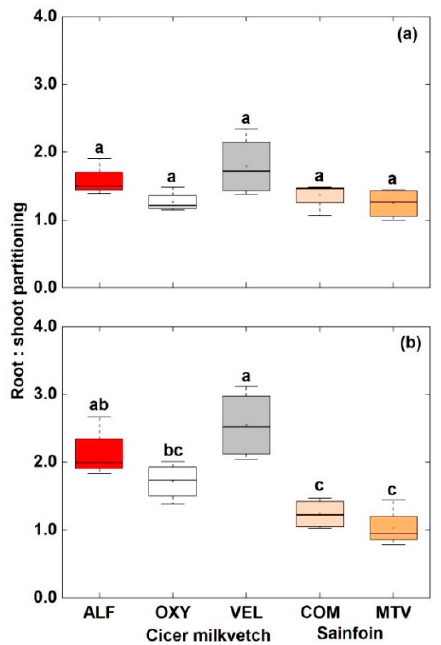
Figure 3. Root:shoot ratio in biomass ( a ) and quantitative nitrogen ( b ) among legumes species and cultivars ( n = 4) grown under controlled environment conditions. ALF = alfalfa, OXY = Oxley II milkvetch, VEL = Veldt milkvetch, COM = Common sainfoin, MTV = Mountainview sainfoin. The box is comprised of the 75th percentile, median, and 25th percentile, while the upper and lower whiskers are the maximum and minimum values, respectively. Boxes with the same letters indicate no significant differences among legume cultivars within a panel ( p > 0.05) according to Tukey’s HSD test.